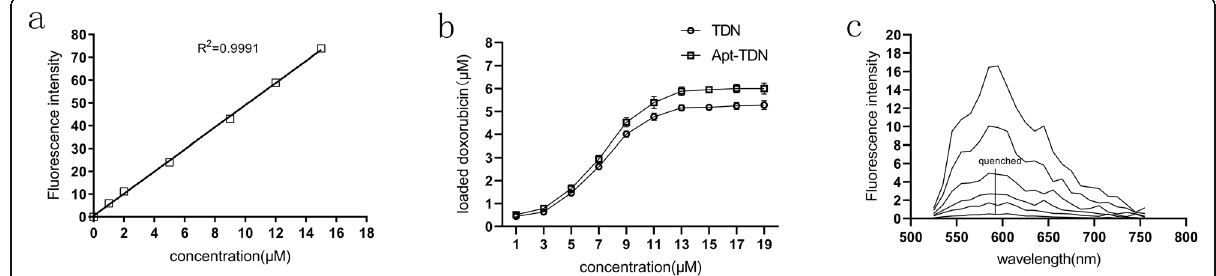
Fig. 3 a A standard curve of DOX concentrations in PBS buffer; λ ex = 480 nm and λ em = 590 nm. The amount of DOX carried by the TDN and Apt-TDN. b DOX intercalated into the double-strand DNA of the TDN and Apt-TDN. When the DOX concentration reached 14 μ M and the intercalated DOX concentration in the TDN and Apt-TDN peaked at 5.5 μ M and 6.0 μ M, respectively, a single DNA tetrahedron could carry 55